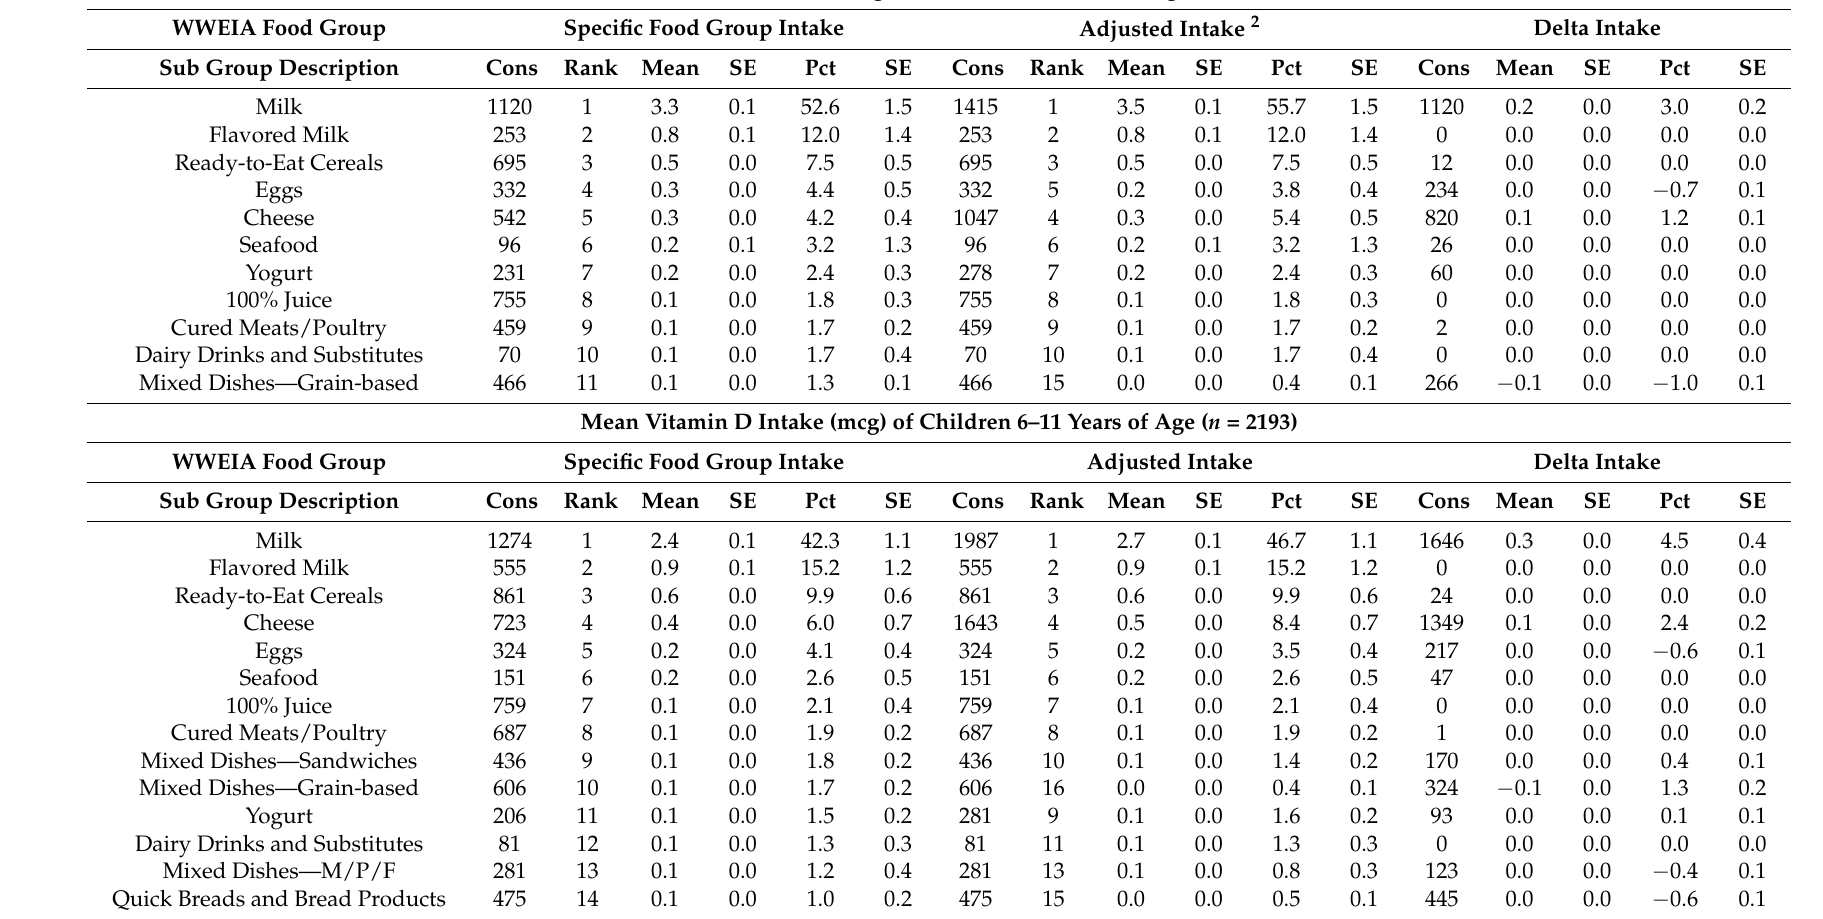
Table 4. Food/food group sources 1 of mean vitamin D intake (mcg) among US children aged 2–18 years ( N = 5876): National Health and Nutrition Examination Survey